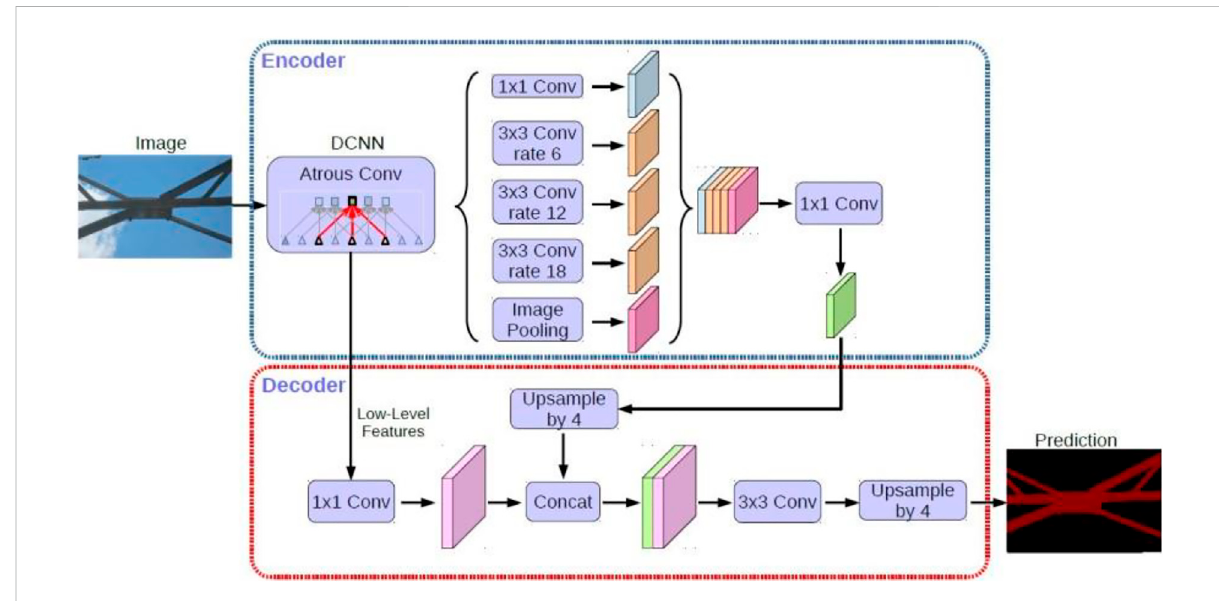
FIGURE 2 Algorithm fl ow of image segmentation based on